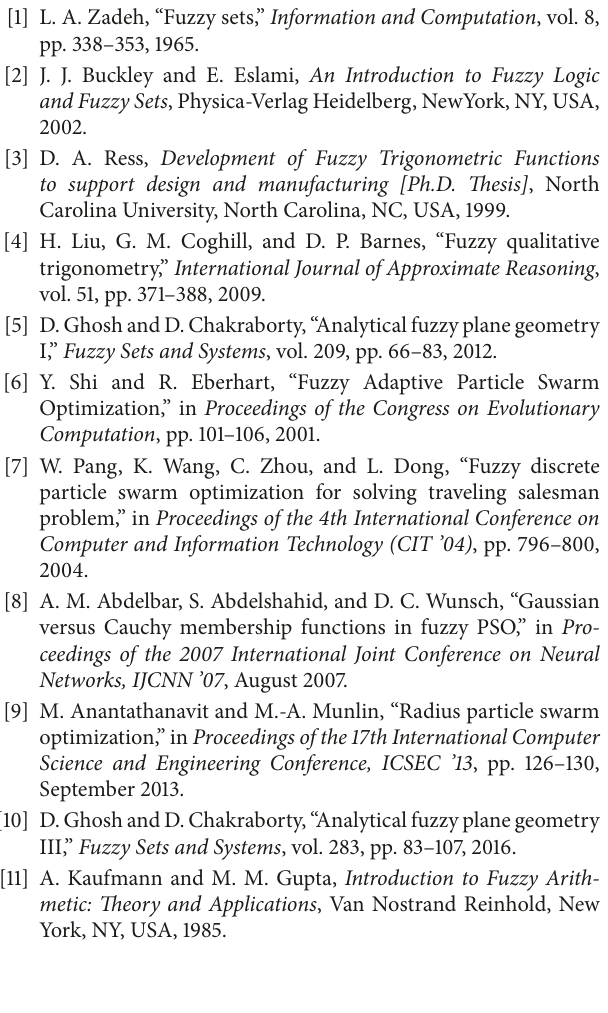
Figure 12: Neighbourhood obtained using 𝛼 -cuts.